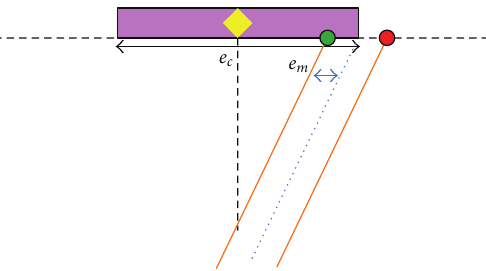
Figure 14: Ratio calculation by taking into account shadows. Case B configuration.